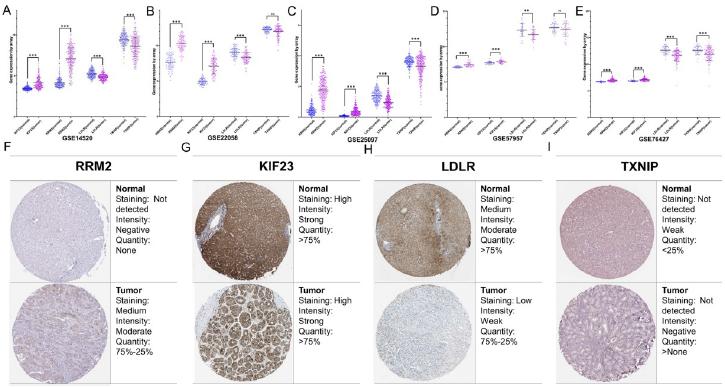
Fig 7. Gene expression analysis validation. External validation data set downloaded from GEO including (A) GSE14520, (B) GSE22058, (C) GSE25097, (D) GSE57957, and (E) GSE76427 used to compare the differential expression of the target genes between HCC and para-cancerous tissues. The immunohistochemical images from the HPA database showed the expression of (F) RRM2, (G) KIF23, (H) LDLR, and (I) TXNIP in HCC tumor and normal